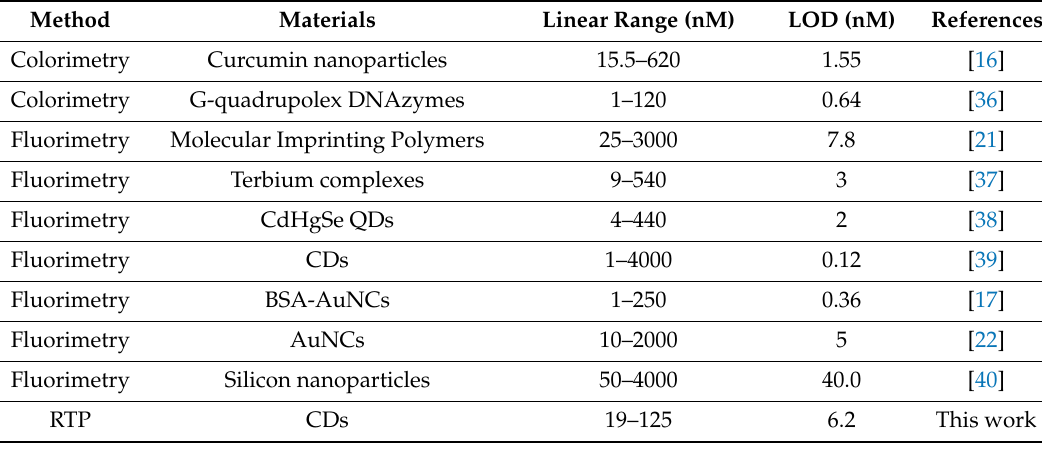
Table 1. Comparison of performance of proposed method for Hb with literature.